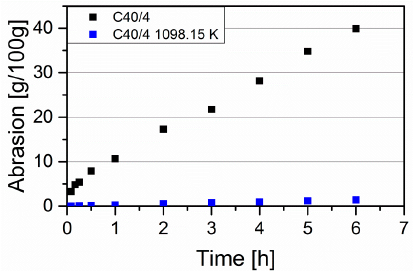
Figure 6. Fluidized bed abrasion tests of uncoated C40/4 and C40/4 coated at 1098.15 K (Table S5).